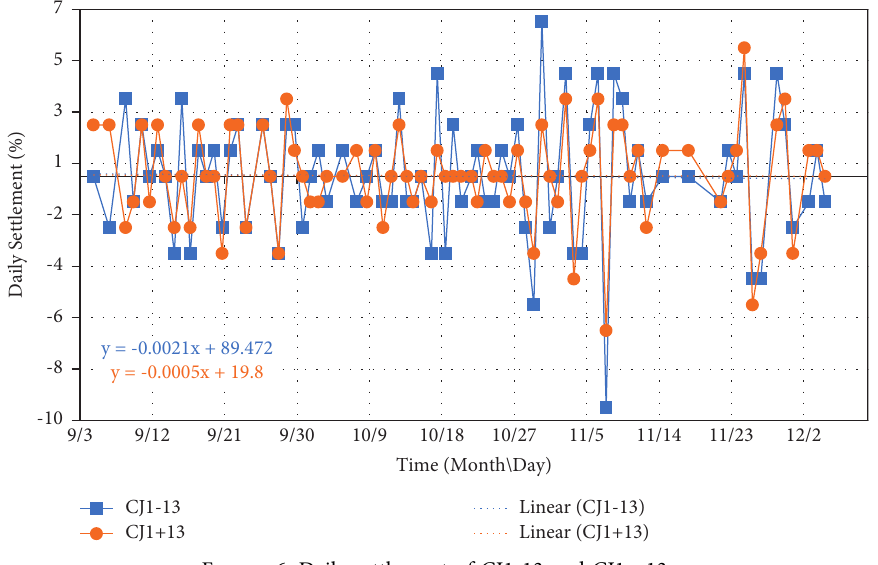
Figure 6: Daily settlement of CJ1-13 and CJ1 +13.